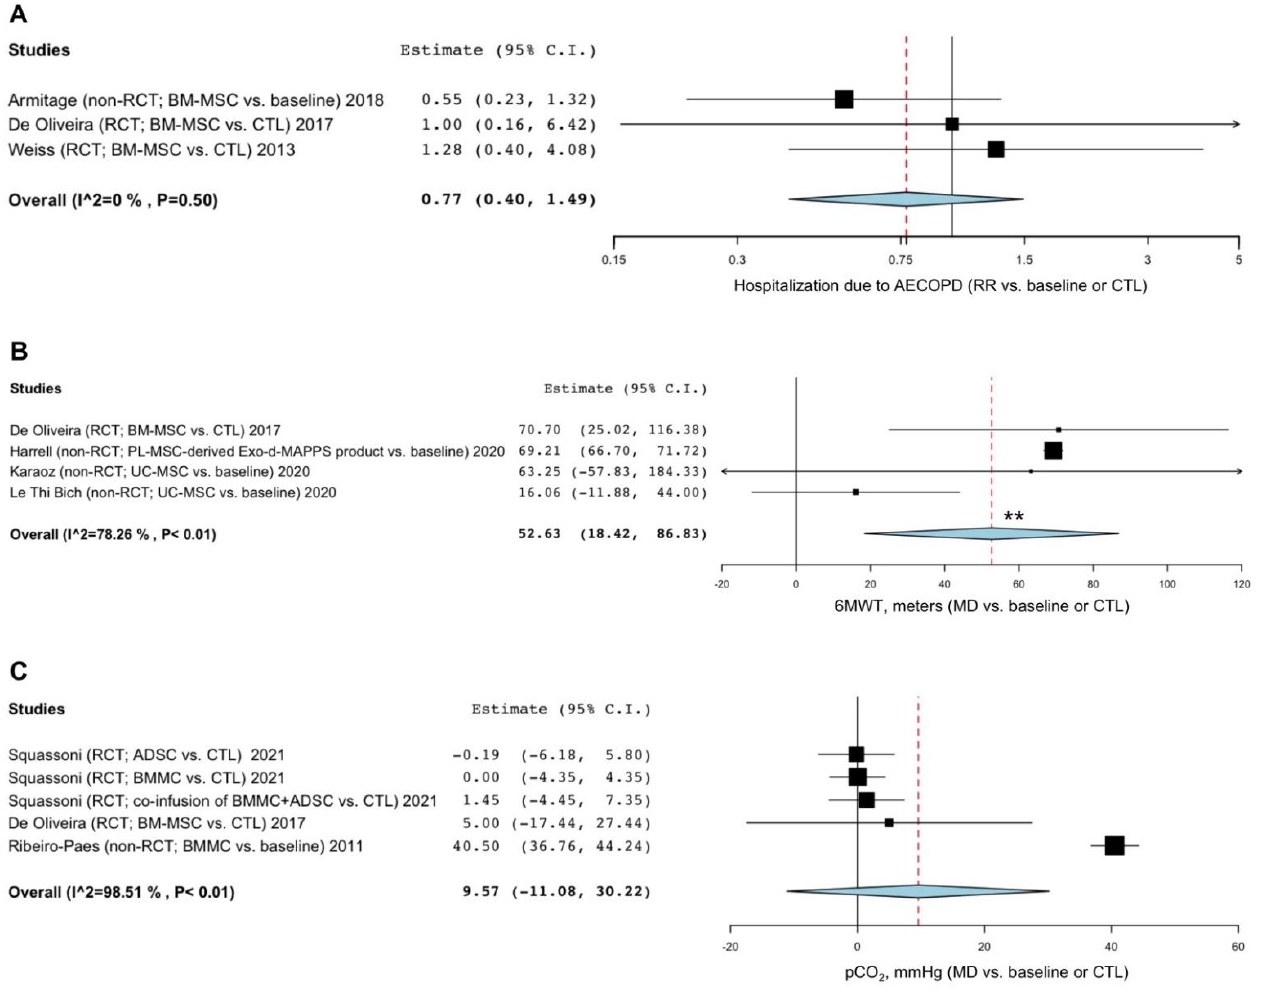
Figure 3. Forest plots of the impact of stem cell-based regenerative therapies vs. baseline or CTL on the risk of hospitalization due to AECOPD ( A ), 6MWT ( B ), and pCO2 ( C ). ADSC: adipose tissue- derived stem cells; AECOPD: acute exacerbation of COPD; BMMC: bone marrow mononuclear cells; BM-MSC: bone marrow-derived mesenchymal stem cells; COPD: chronic obstructive pulmonary disease; CTL: control; MD: mean difference; pCO2: partial pressure of carbon dioxide; PL-MSC: placenta-derived mesenchymal stem cells; RCT: randomized controlled trial; RR: relative risk; UC- MSC: umbilical cord mesenchymal stem cells; 6MWT: 6 min walking test. ** indicates p -value < 0.01.